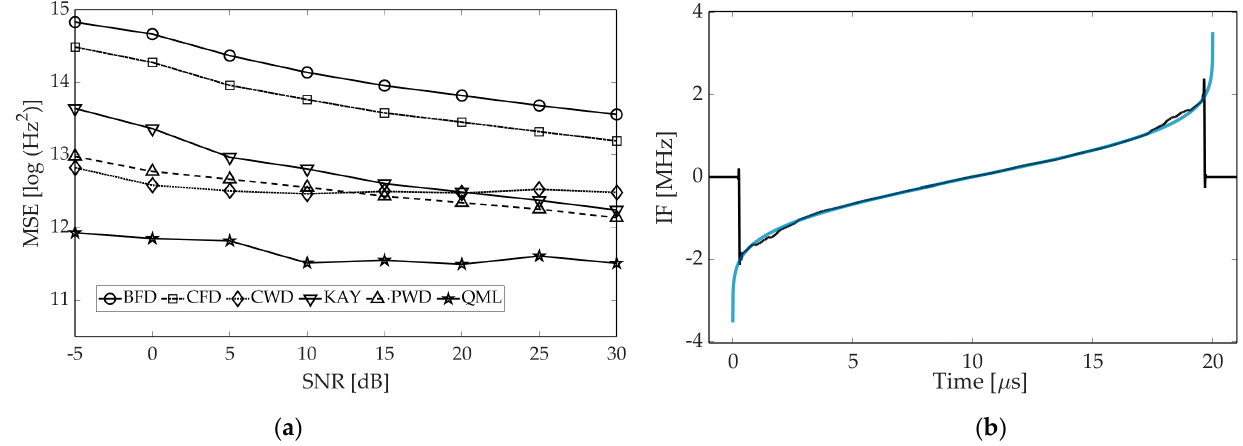
Figure 8. ( a ) The mean squared error achieved by considered IF estimation methods, evaluated on pulse edges only. The error was determined for time samples corresponding to 7% of pulse duration for both pulse ends. The NLFM A waveform was concerned, as on Figure 6; ( b ) illustration of how an inaccurate IF estimate may cause misclassification in the recognition system.